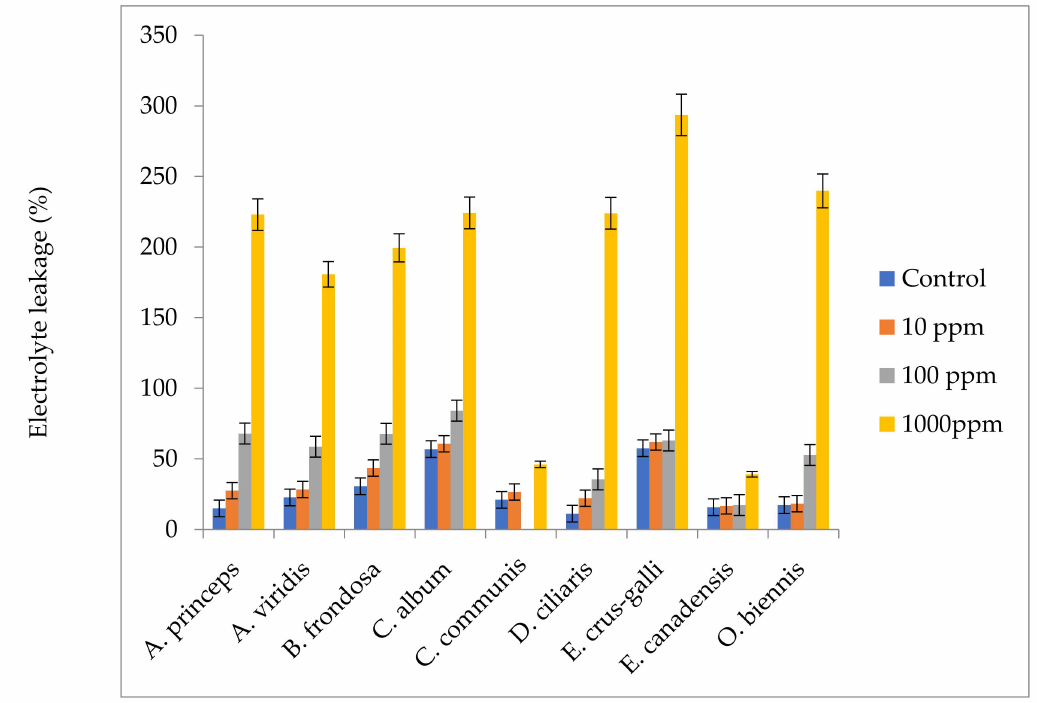
Figure 3. Comparison of electrolyte ion leakage activities of weeds treated with Miscanthus extracts. Values are reported as mean ± standard deviation of three parallel